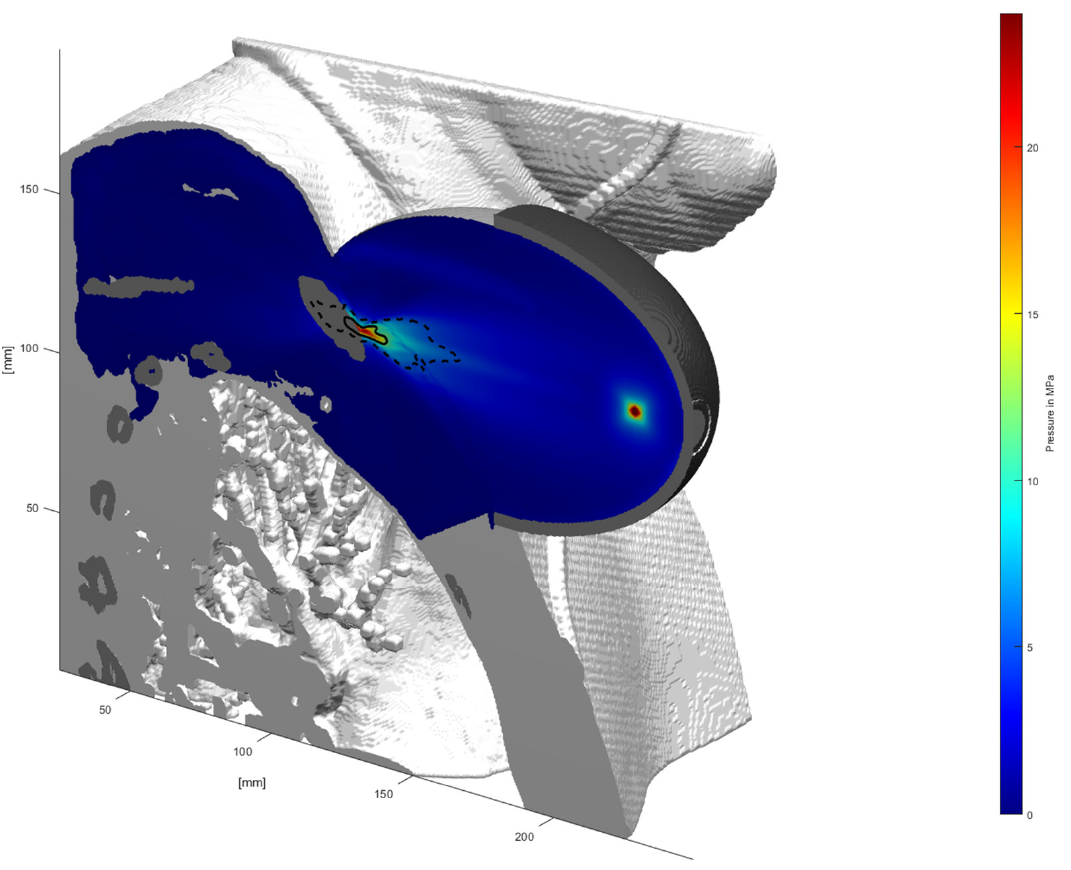
Figure 3. Peak positive pressure distribution: − 6 dB and 5 MPa focal zones are delineated by solid and dashed lines.